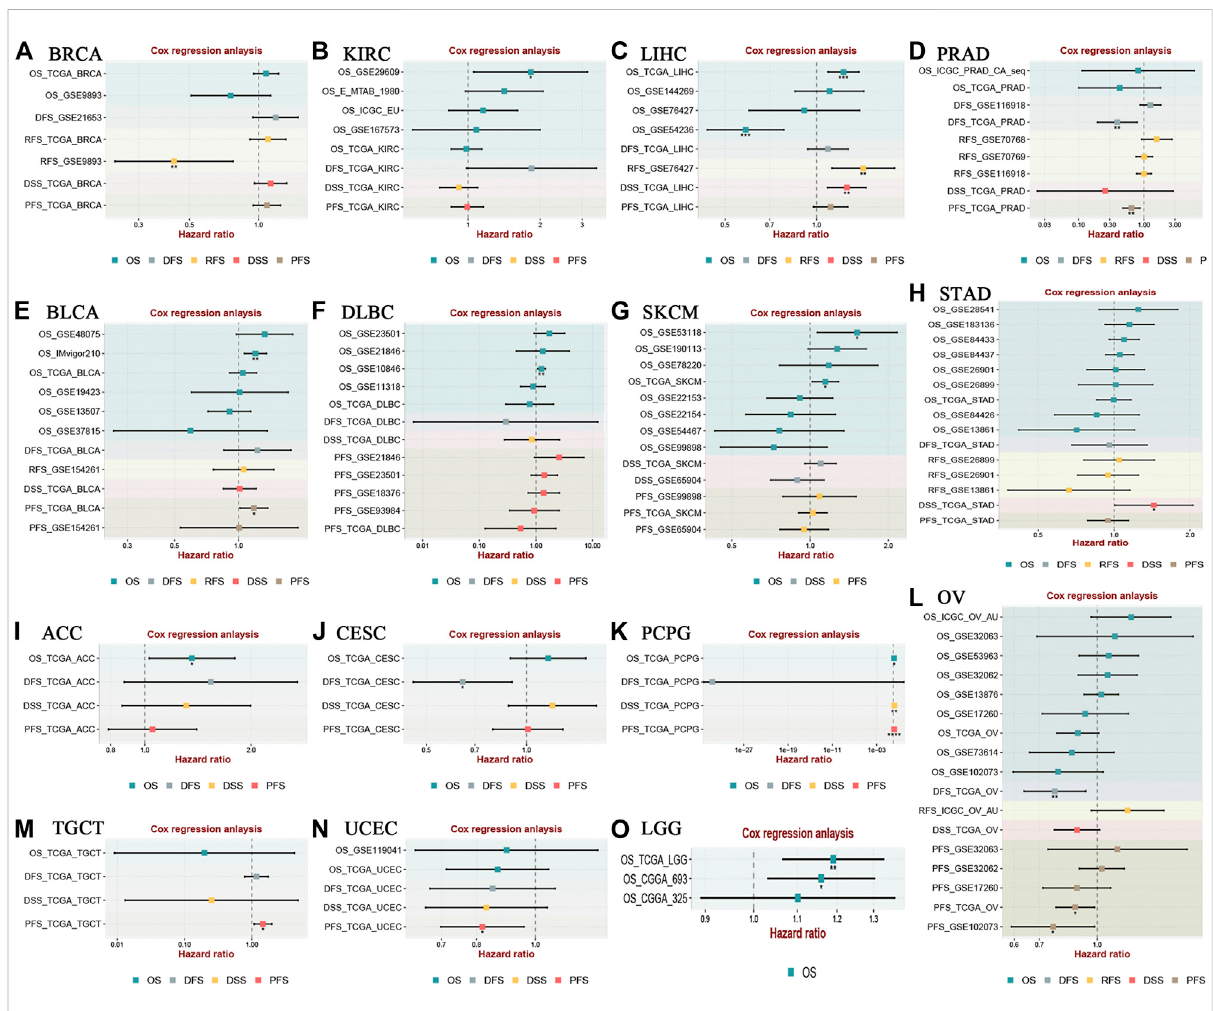
FIGURE 7 Relevance analysis of LINC00958 expression with survival using the Cox method for different types of cancers in BEST (https://rookieutopia. com). Cox regression analysis of (A) BRCA, (B) KIRC, (C) LIHC, (D) PRAD, (E) BLCA, (F) DLBC, (G) SKCM, (H) STAD, (I) ACC, (J) CESC, (K) PCPG, (L) OV, (M) TGCT, (N) UCEC, (O) LGG. * p < 0.05, ** p < 0.01, and *** p <